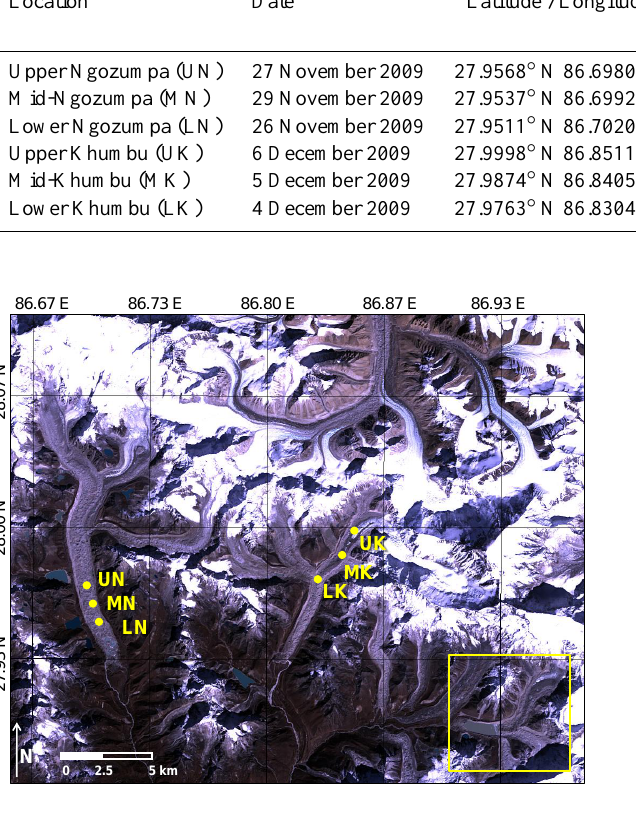
Fig. 2. Landsat TM (31 October 2009) true color composite of the Khumbu Himalaya study area. Ngozumpa glacier (left) and Khumbu glacier (right) in situ measurement locations are labeled as detailed in Table 1. The approximate area presented in the Hy- perion Imja and Lhotse Shar glacier analysis is highlighted with a yellow box in the lower right hand